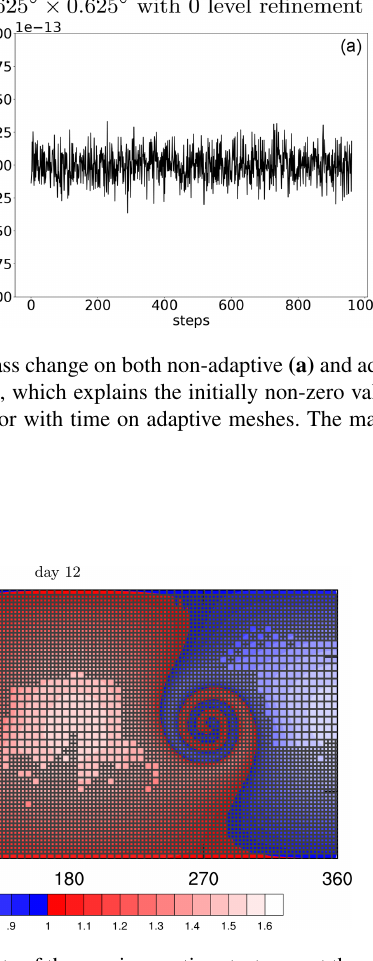
Figure 17. Numerical results of the moving vortices test case at the final time step on a lat–long plane, indicating that the cells around poles are not refined. The numerical results have the resolution of a 5 ◦ × 5 ◦ coarse grid with one-level refinement and an interpolated wind